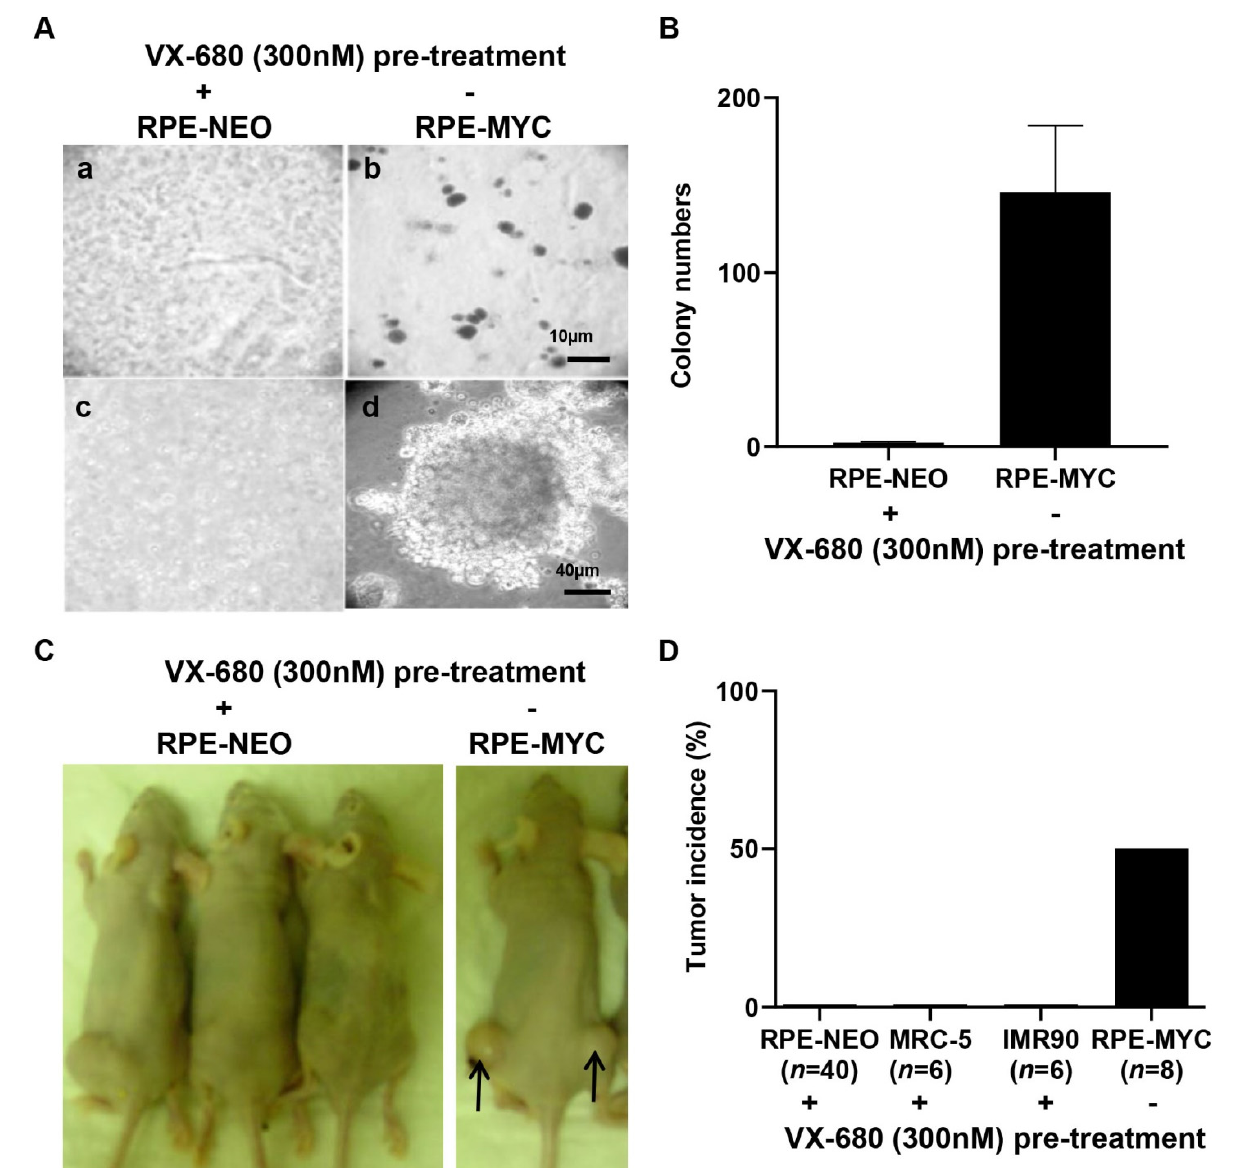
Figure 6. The tetraploid cells induced by a brief treatment of euploid cells with VX-680 are not tumorigenic. RPE-NEO cells were treated with 300 nM of VX-680 for 3 days to induce tetraploidy in about 70% of the population before being analyzed for tumorigenic potential. Untreated RPE-MYC cells were used as a positive control. ( A ) Ten thousand RPE-NEO cells pretreated with VX-680 were assayed for anchorage-independent growth in soft agar ( a , c ). The same number of untreated RPE-MYC cells was used in ( b ) and ( d ). The scale bar in b indicates 10 µm, whereas that in d is 40 µm. ( B ) The colonies in 20 randomly chosen fields were quantified under a tissue culture microscope at a magnification of ×200. ( C , D ) The indicated cells pretreated with VX-680 and untreated RPE-MYC cells were assayed for tumor formation in immunocompromised female Nu/Nu mice. Both flanks of each mouse were implanted with one million cells per flank. n indicates the number of injection sites. Representative images are presented in ( C ). The percentage of the injection sites that formed tumors is presented in ( D ). Note the lack of clear cell, distinguishable clusters in ( A ) and ( C ) compared to ( B ) and ( D ), as these images are of single cells or small clusters within a three-dimensional background of agarose matrix.